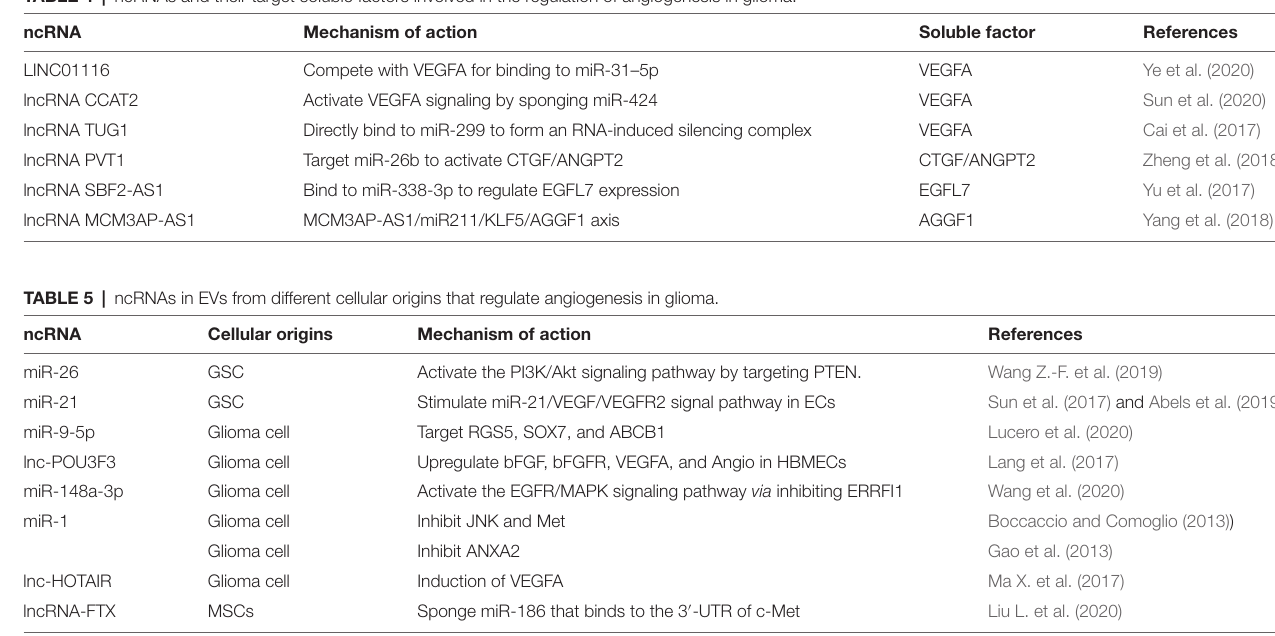
TABLE 4 | ncRNAs and their target soluble factors involved in the regulation of angiogenesis in glioma.